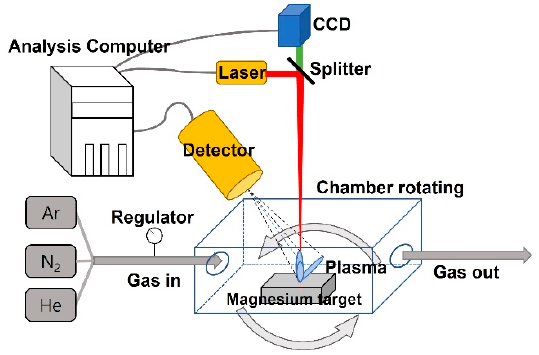
Figure 3. Experimental setup.